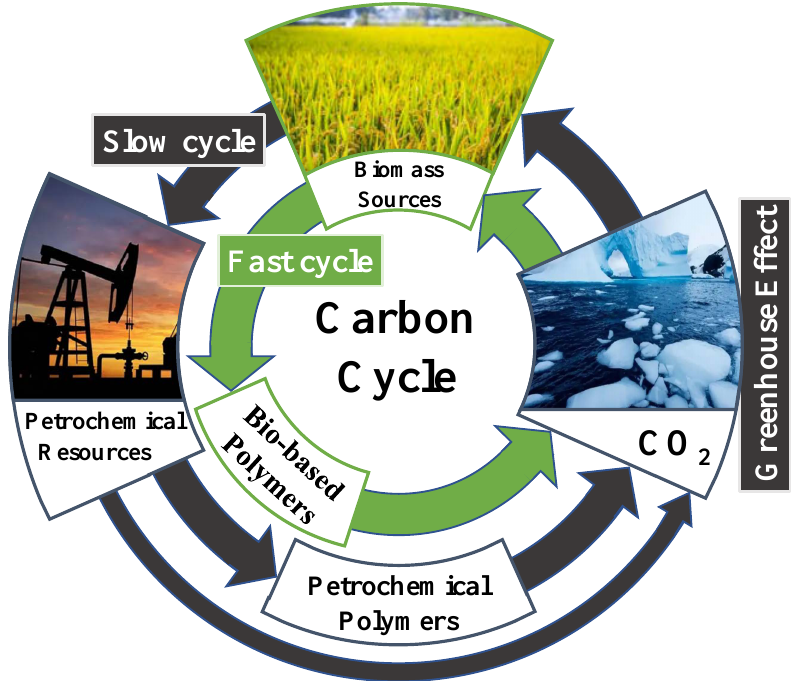
Figure 1 . Carbon cycle